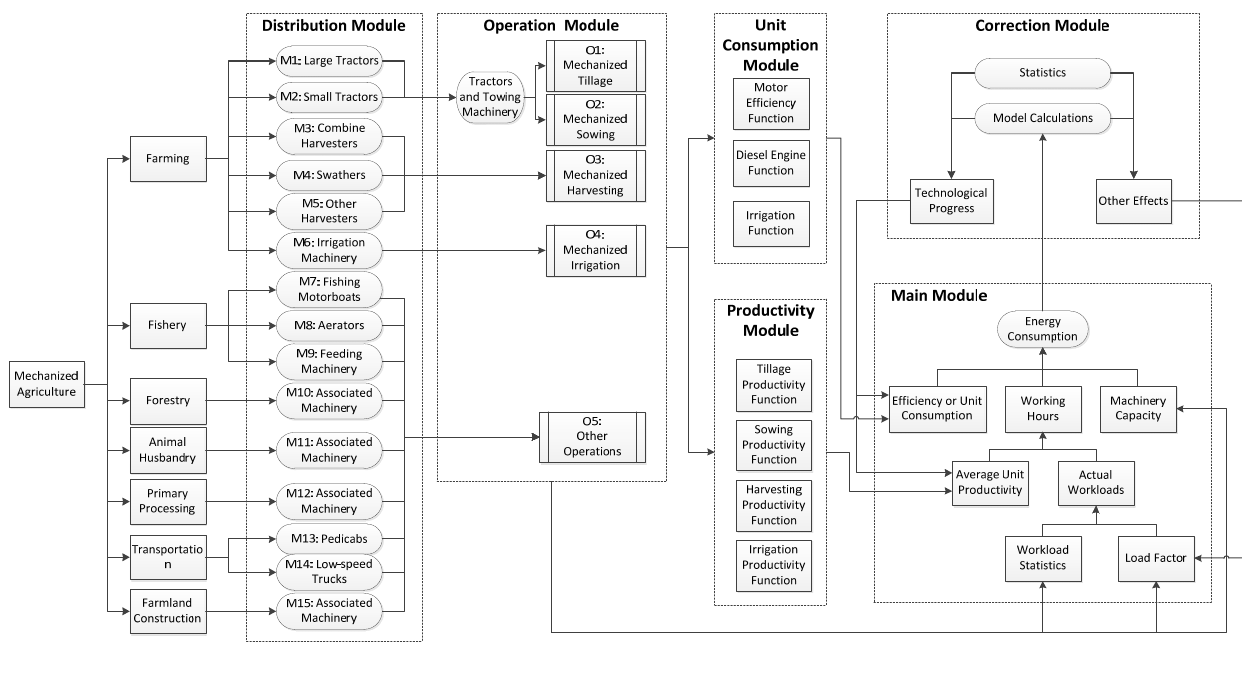
Figure 1. Overall structure of